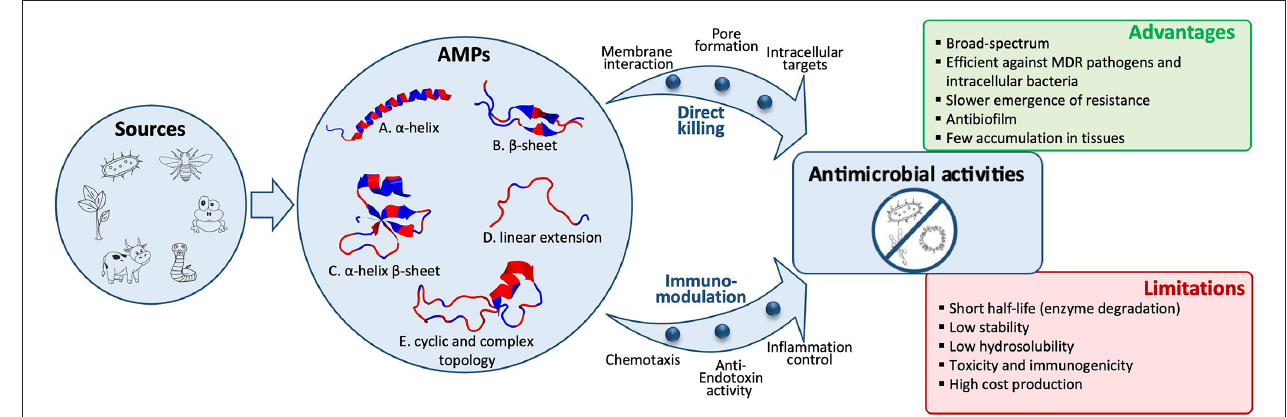
FIGURE 1 | Structural diversity of antimicrobial peptides (AMPs) and their activities against bacteria, viruses, or fungi. A wide variety of biological sources, including microbes, insects, amphibians, reptiles, mammals, or plants, produce AMPs, which are classified into five structural classes. Representative examples of these five classes are shown as a cartoon representation and colored by hydrophobicity [sourced from the RCSB Protein Data Bank (https://www.rcsb.org/)]: (A) α -helical structure of human LL-37 (PDB entry: 2K6O); (B) β -sheet structure of bovine lactoferricin (PDB entry: 1LFC); (C) α -helix and β -sheet structure of human beta-defensin-1 (PDB entry: 1IJV); (D) Linear extension structure of bovine indolicidin (PDB entry: 1G89); (E) Cyclic structure of Bacillus subtilis Subtilisin A (PDB entry: 1PXQ). Direct pathogen killing and immunomodulatory activities of AMPs lead to antibacterial, antiviral, and antifungal activities. AMPs’ advantages and limitations